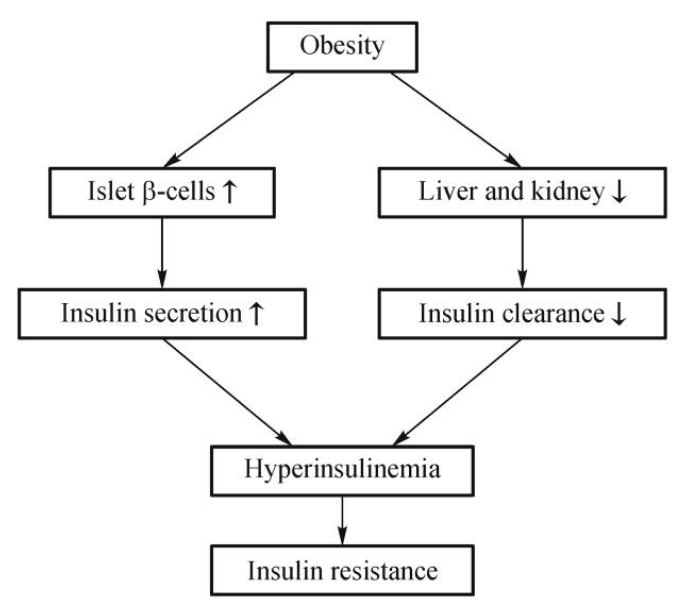
Figure 1 . Hyperinsulinemia in obesity